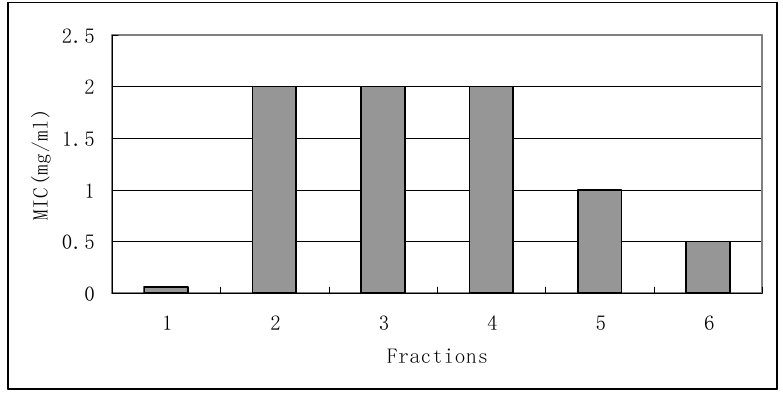
Figure 2. Antimicrobial activity of fractions 1-6 against B . subtilis